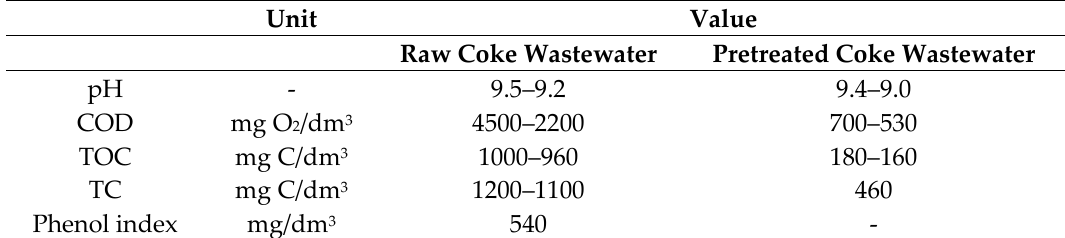
Table 1. Shortened description of coke wastewater, raw and after pretreated